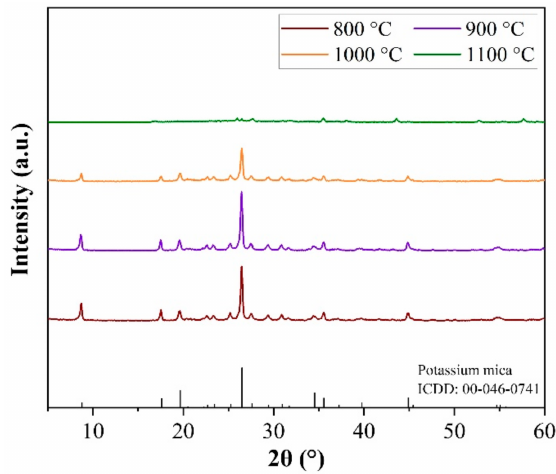
Figure 8. XRD patterns of mica ceramics sintered at different